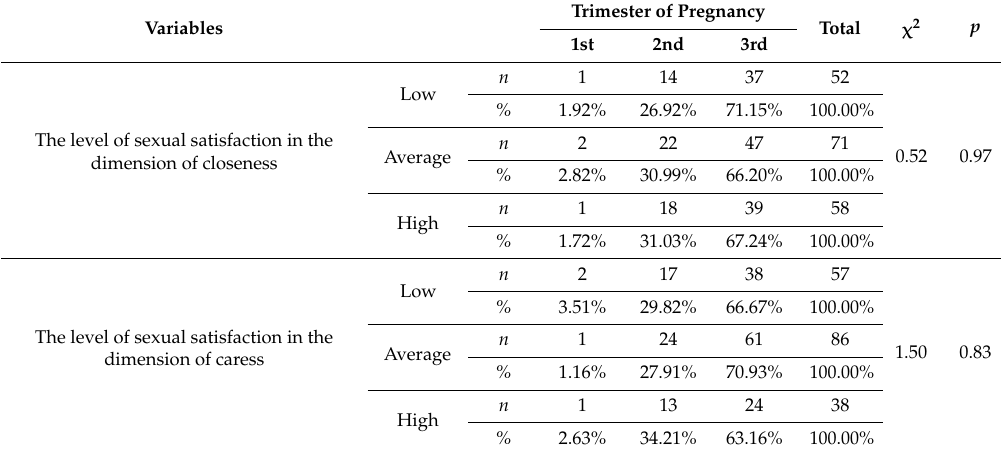
Table 12. Relationship between the level of sexual satisfaction and the trimester of pregnancy.